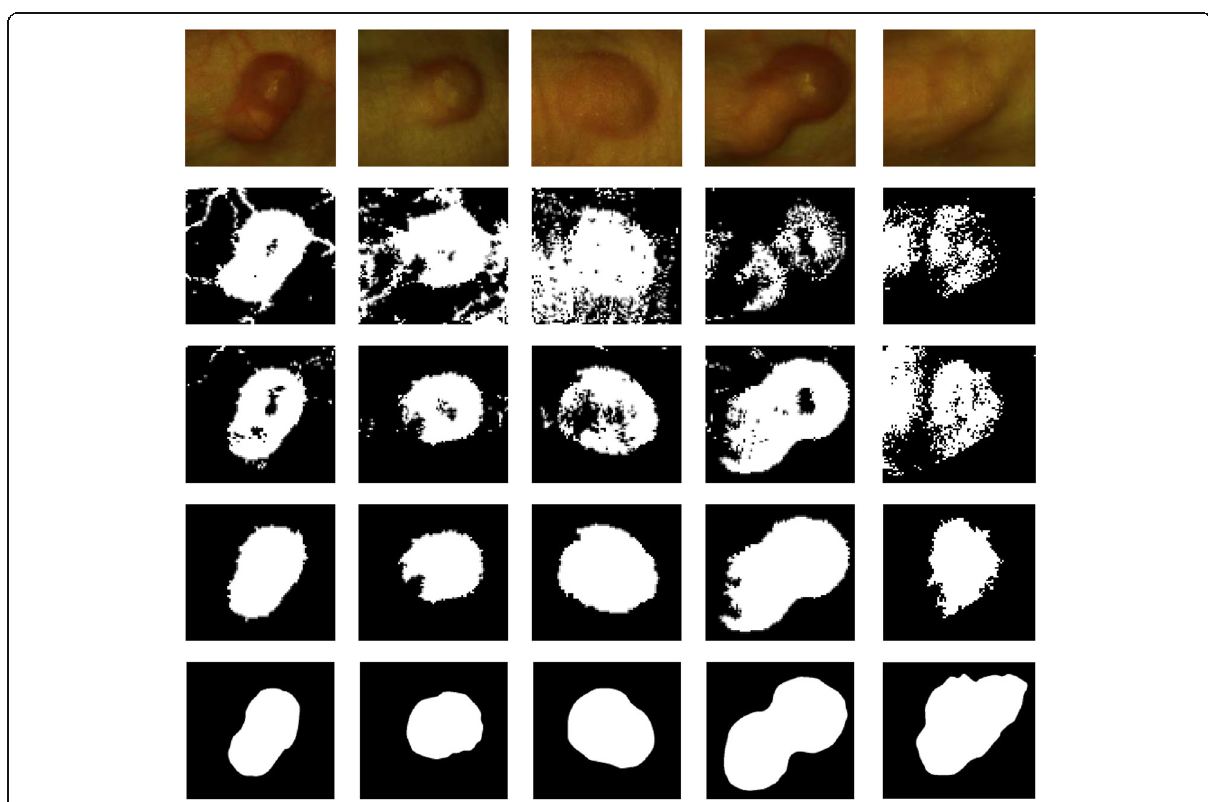
Fig. 9 Qualitative evaluation of the cancer detection from five mice. Row 1st: RGB composite images generated from the hypercube, 2nd: The initial detection results, 3rd: The improved results obtained by the adaptive weighted learning, 4th: The final results refined by post-processing, and 5th: The gold standard